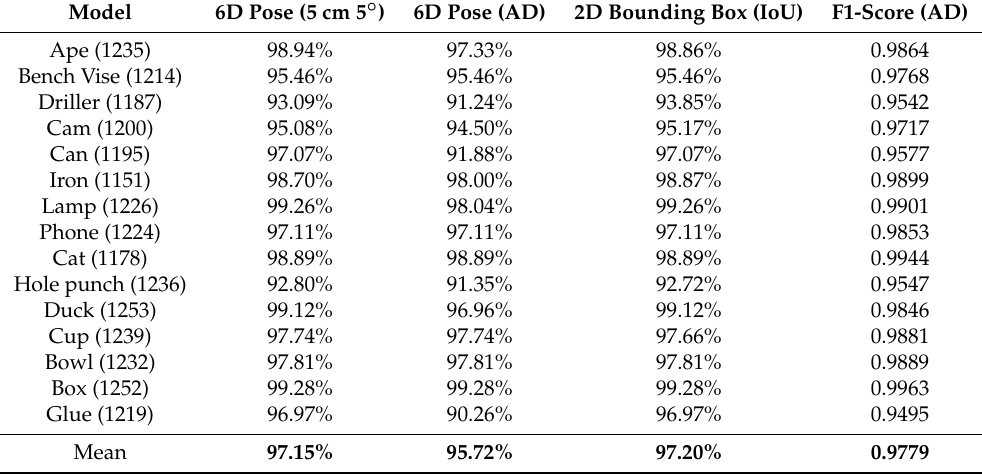
Table 2. Results of our detection and pose estimation system on the LINEMOD dataset [24] using different metrics. The percentage is calculated as the number of times that the pose was estimated correctly with respect to the total number of images for each of the sequences. AD: average distance; IoU: intersection over